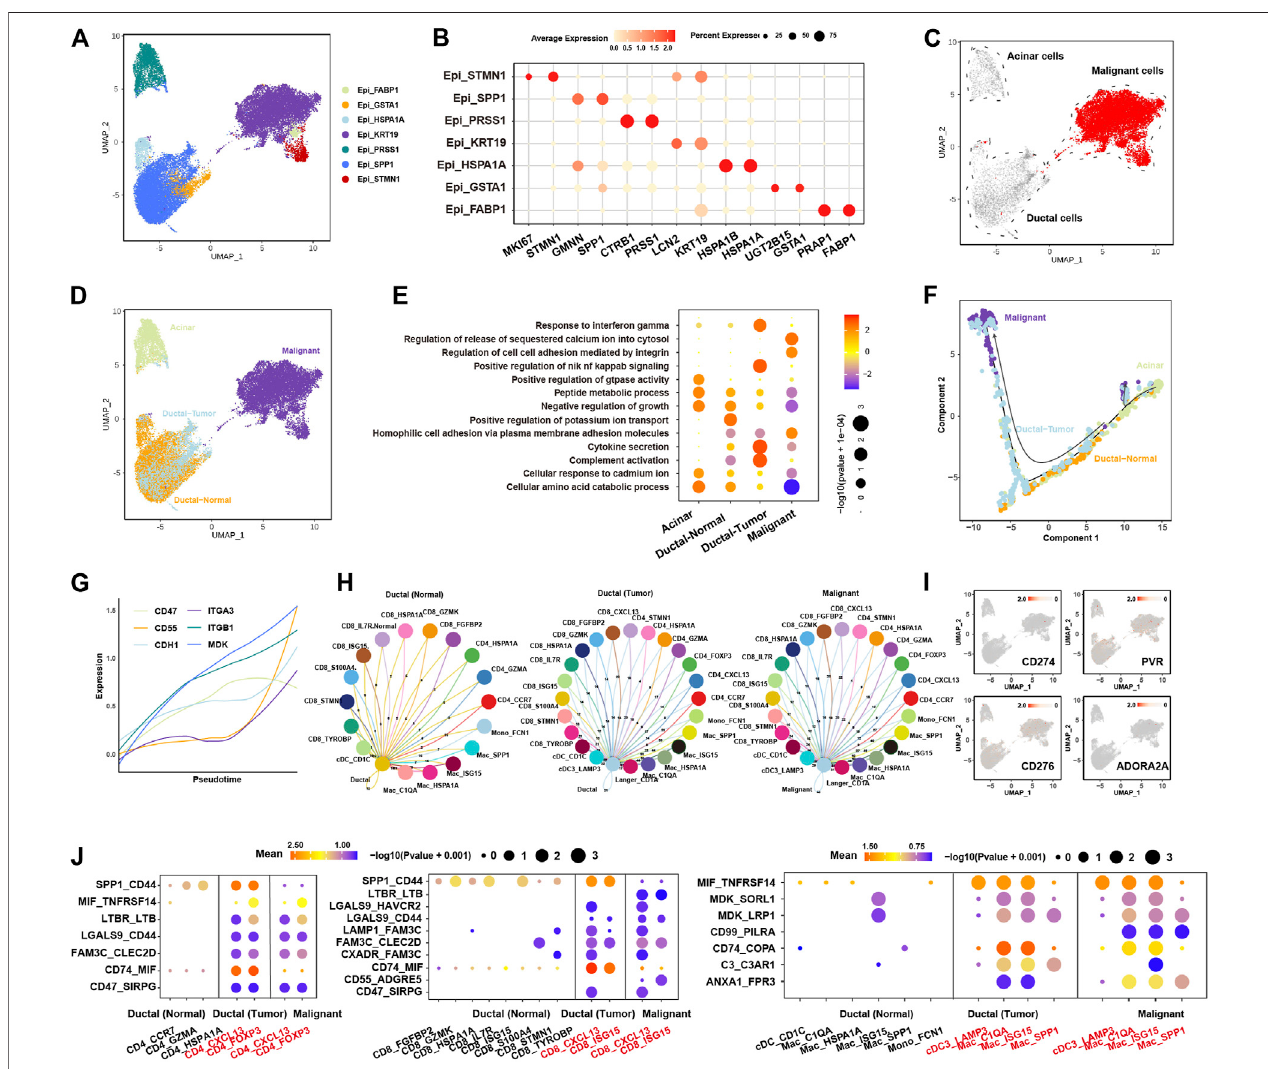
FIGURE 2 | Characteristics and evolution of epithelial cells during cancer progression and their ligand-receptor communications with immune cells in PDAC. (A) , UMAPplotofepithelialcells,color-codedforthesubclustersofepithelialcells. (B) ,Dotplotshowingtheexpressionofmarkergenesineachsubcluster. (C) ,UMAPplotof epithelialcells,color-codedfortheCNVscorecalculatedbyinfercnv. (D) ,UMAPofepithelialcells,color-codedforthefourmajorsubclusters:acinarcells,malignantcells, ductal-normal cells and ductal-tumor cells. (E) , dot plot showing the enriched pathways in the four major subclusters. The color of each dot represents the normalized enrichment score (NES), while the size of the dot represents p -value. (F) , trajectory analysis showing the pseudotime of the four major subclusters. (G) , line plotshowingtheexpressionofcelladhesionmolecules(ITGA3,CD47,MDK,ITGB1,CD55,andCDH1)alongthepseudotime.Eachlinewithdifferentcolorrepresentsa gene. (H) ,circosplotshowingtheligand-receptorinteractionsbetweenimmunecellsandductal-normalcells(leftpanel),ductal-tumorcells(middlepanel),andmalignant cells (right panel). (I) , UMAP of epithelial cells showing the expression of known checkpoint genes (CD274, PVR, CD276 and ADORA2A). (J) , the signi fi cantly enriched ligand-receptor pairs between in CD4 + T cells (left panel)/CD8 + T cells (middle panel)/myeloid cells (right panel) and ductal-normal cells/ductal-tumor cells/ malignant cells.